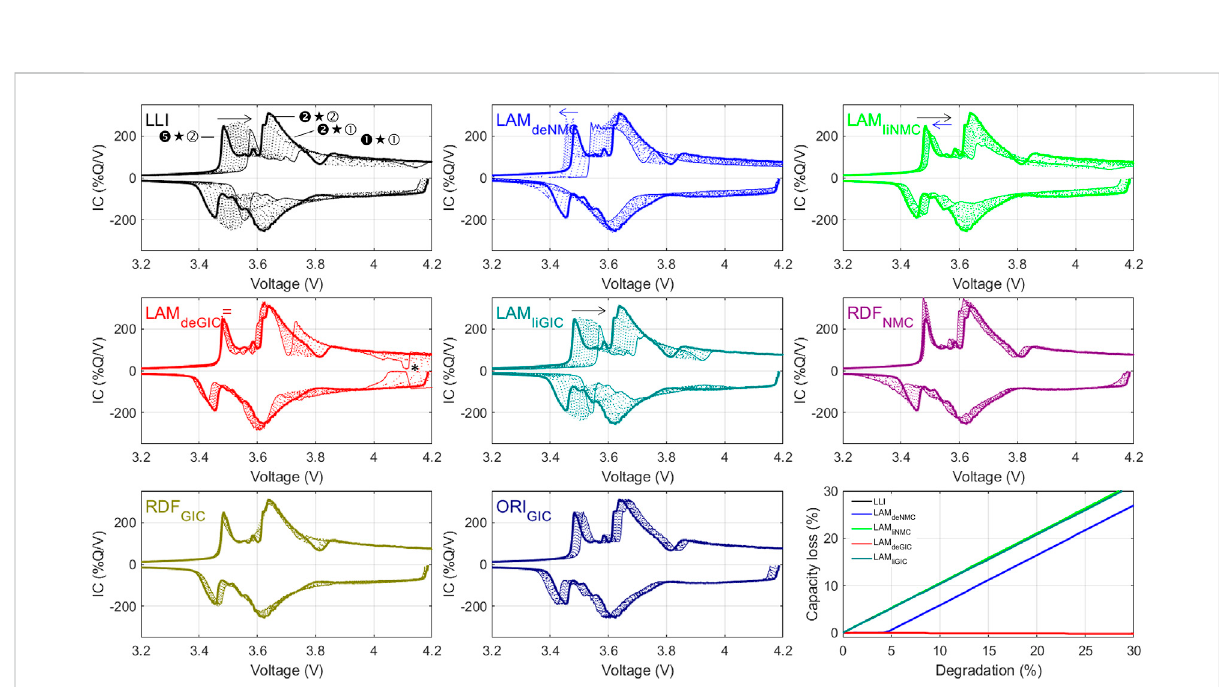
FIGURE 7 Degradation map for aGIC/NMC cell for up to 30% of LLI and LAMs and up to 5x kinetic and resistance increases with 2% interval (thick full line: initial cycle, dotted lines: intermediate cycles, and thin full line: fi nal